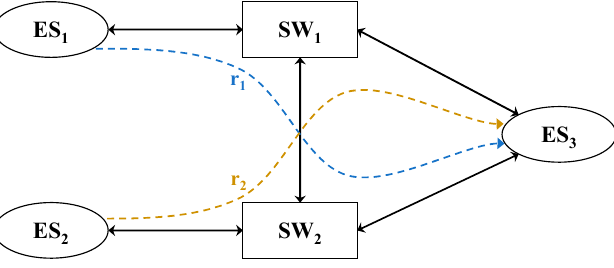
Figure 1. Example of a simple time-sensitive networking (TSN) topology.